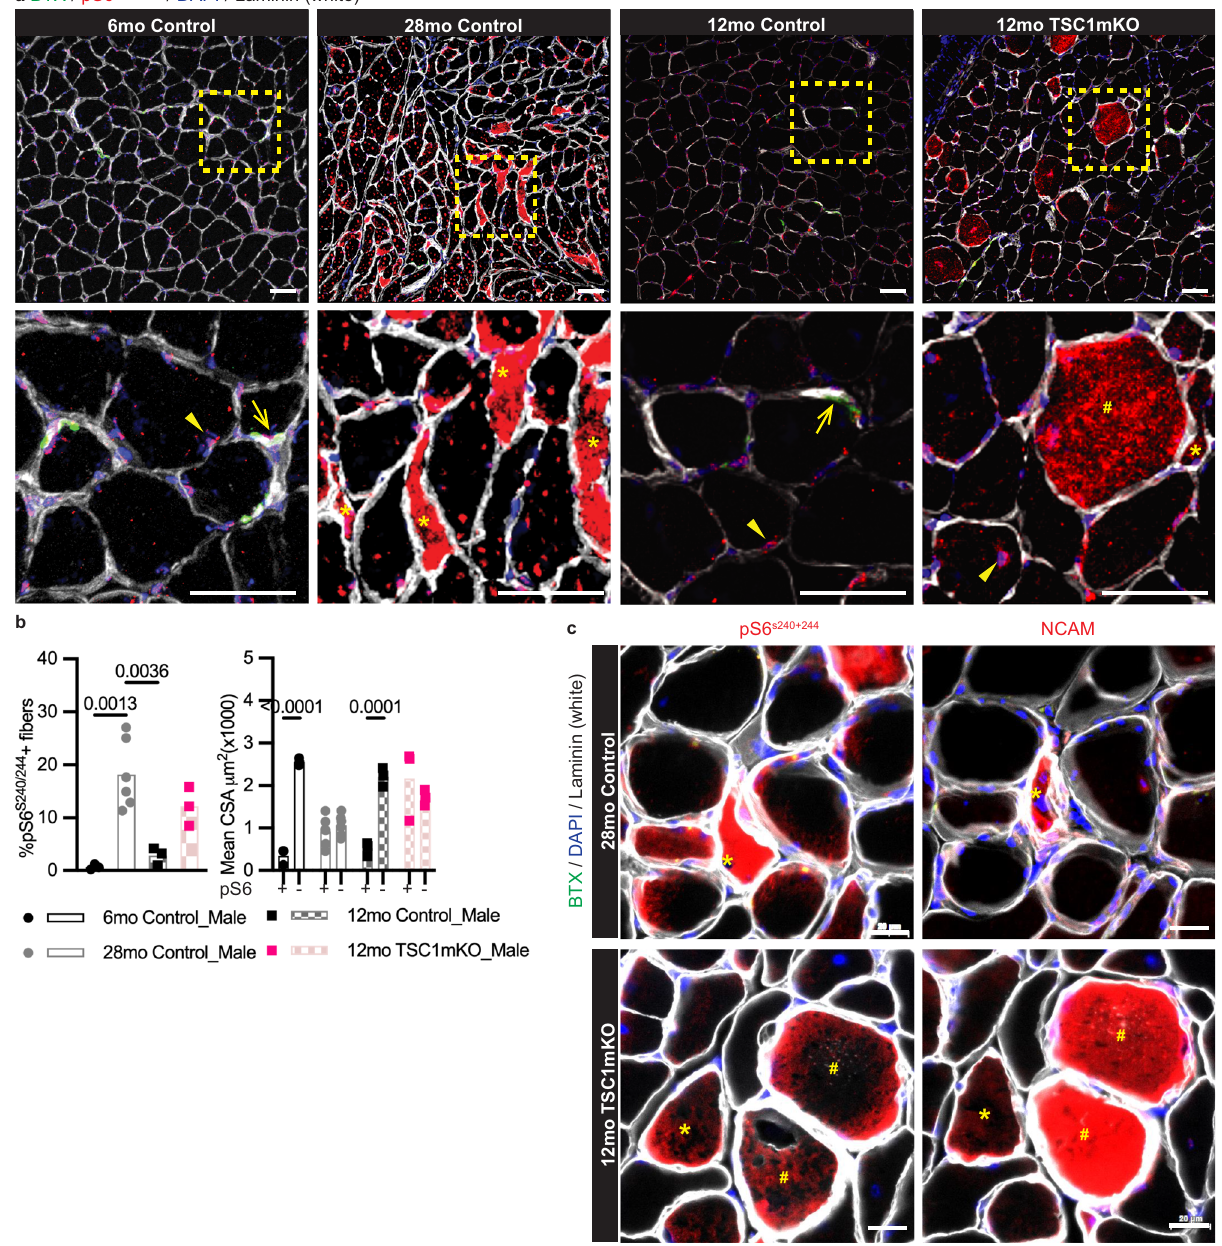
Fig.2|ChronicactivationofmTORC1inagingmuscle.a Representativeconfocal images of BTX (green), pS6 S240+244 (red), DAPI (blue) and Laminin (white) staining from cross-sections of the gastrocnemius muscle of 6- and 28-month-old male control mice and 12-month-old control and TSC1mKO male mice (6mo Control, n =3; 28mo Control, n =6; 12mo Control, n =3; 12mo TSC1mKO, n =3). The insets areshowninthebottompanels.Asterisks=intracellularpS6 S240+244 inangular,odd- shaped fi bers; Hash=intracellular pS6 S240+244 accumulation in abnormally enlarged fi bers; Open arrow=junctional pS6 S240+244 ; Arrowhead=pS6 S240+244 in the nucleus, includingcentralnucleus.Scalebars=50 μ m. b Quanti fi cationofthepercentageof pS6 S240+244 -positive myo fi bers (leftpanel;statisticalsigni fi cance was determined by one-way ANOVA followed by Tukey ’ s post-hoc pairwise comparison is used for statistical analysis) and mean CSA of pS6 S240+244 -positive (pS6+) and pS6 S240+244